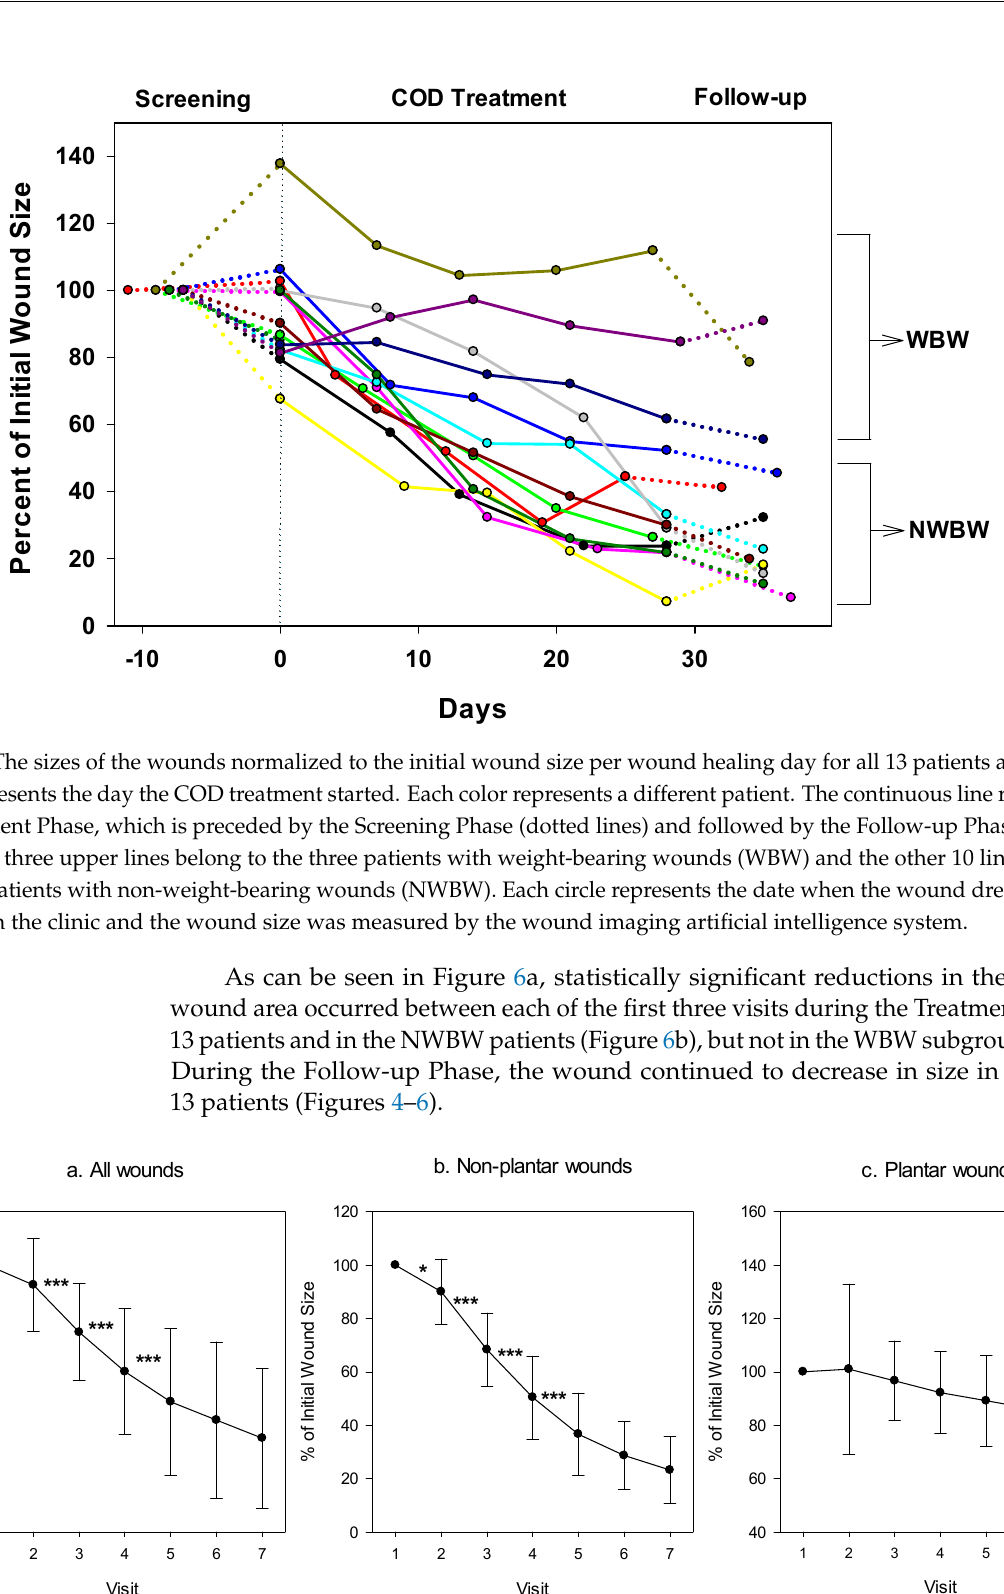
Figure 6. Percentage of wound area during the trial as compared to the wound size at the commencement of the study. The mean ± standard deviation of the wound area of ( a ) all patients, ( b ) of those suffering from a non-plantar foot wound, and ( c ) those suffering from a plantar wound. A paired t -test was conducted between each visit and the next one; * p < 0.05; *** p <